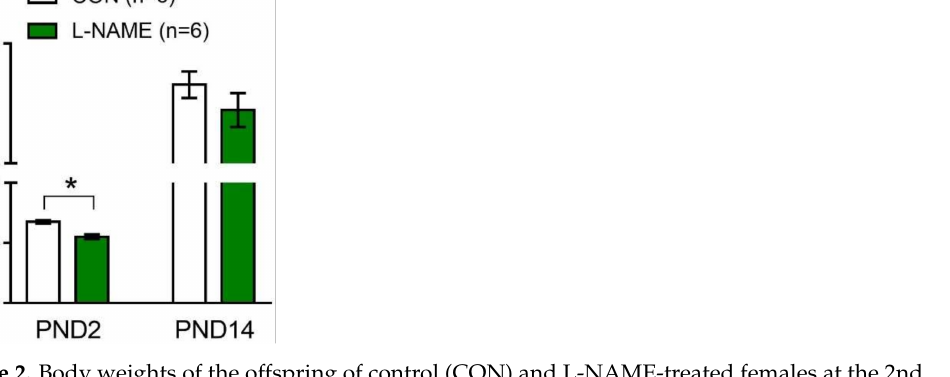
Figure 2. Body weights of the offspring of control (CON) and L-NAME-treated females at the 2nd (PND2) and the 14th postnatal days (PND14). Data are presented as the mean ± S.E.M., n , number of litters. * p < 0.05 (unpaired Student’s t -test). Table 2. Serum parameters of pups in control (CON) and L-NAME groups on the second and the 14th postnatal days. Parameters CON